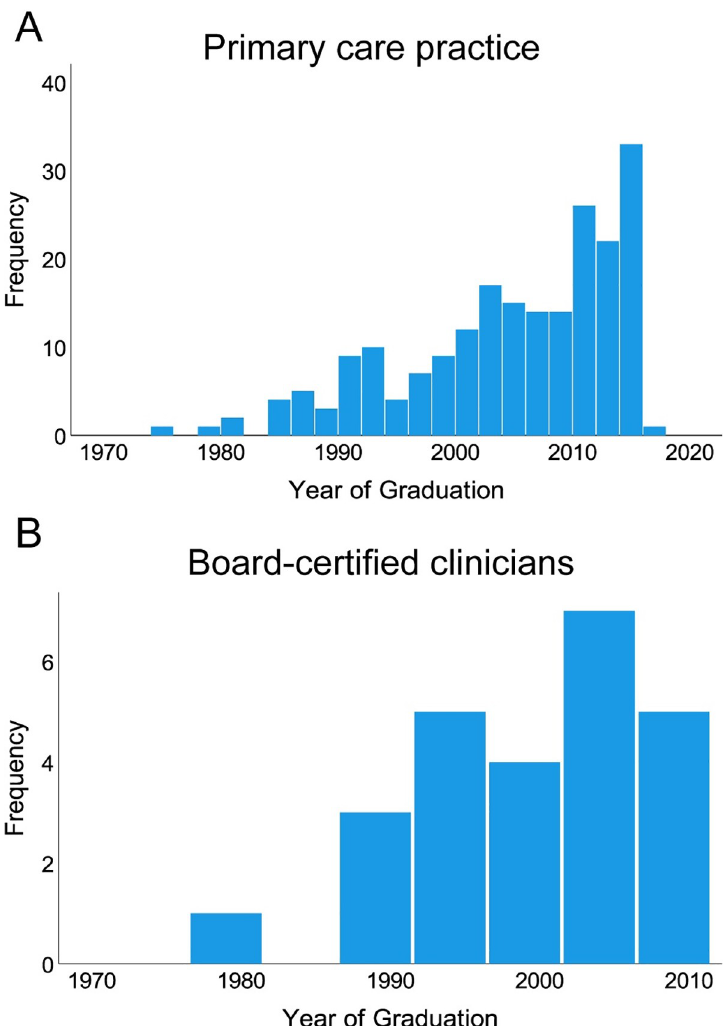
Fig 1. Most respondents graduated after 2000. Histograms showing frequencies of year of graduation for ( A ) veterinarians in primary care practice (PCP), n = 209 and ( B ) board-certified clinicians (BCC), n = 25. Bins represent 2 year periods ( A ) or 5 year periods ( B